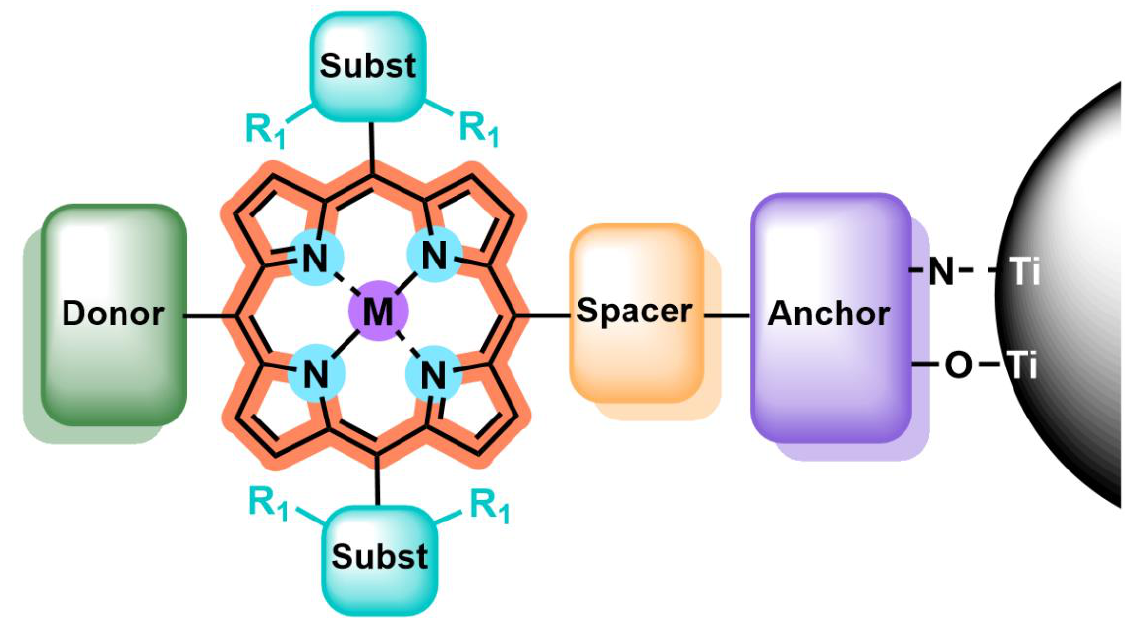
Figure 2. Structural motifs affecting the photocatalytic performance of porphyrin-sensitized TiO 2 semiconductors: metal center, anchoring group, spacer, peripheral substituents and ring core.